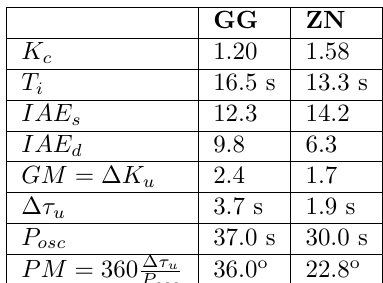
Figure 6: Setpoint step response during tuning with the Ziegler-Nichols’ method.